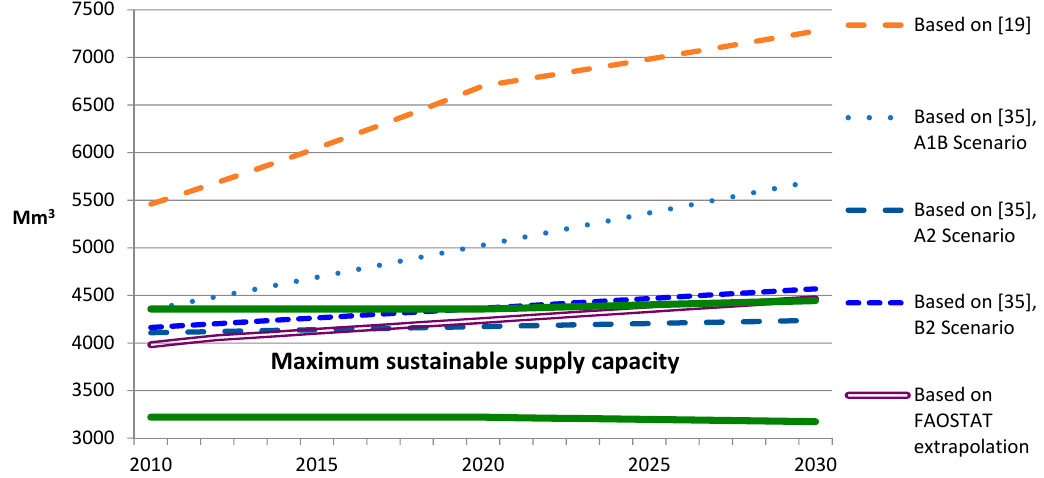
Figure 1. Global consumption scenarios compared to the global forest sustainable supply capacity range of primary timber based on different sources, 2010–2030 Note: Future estimates depict the direction of change based on [19,35] and an extrapolation of past trends from FAOSTAT. Linear annual development is assumed based on data from single points in time. For indicative purposes, the sustainable supply range [31] is extended back to 2010. This is based on a constant space for the period between 2010 and 2020 (e.g., ranging between 3220 and 4360 Mm 3 ), which encompasses the realistic potential ranges using 80% and 90% of NAI in 2010 determined by [31].